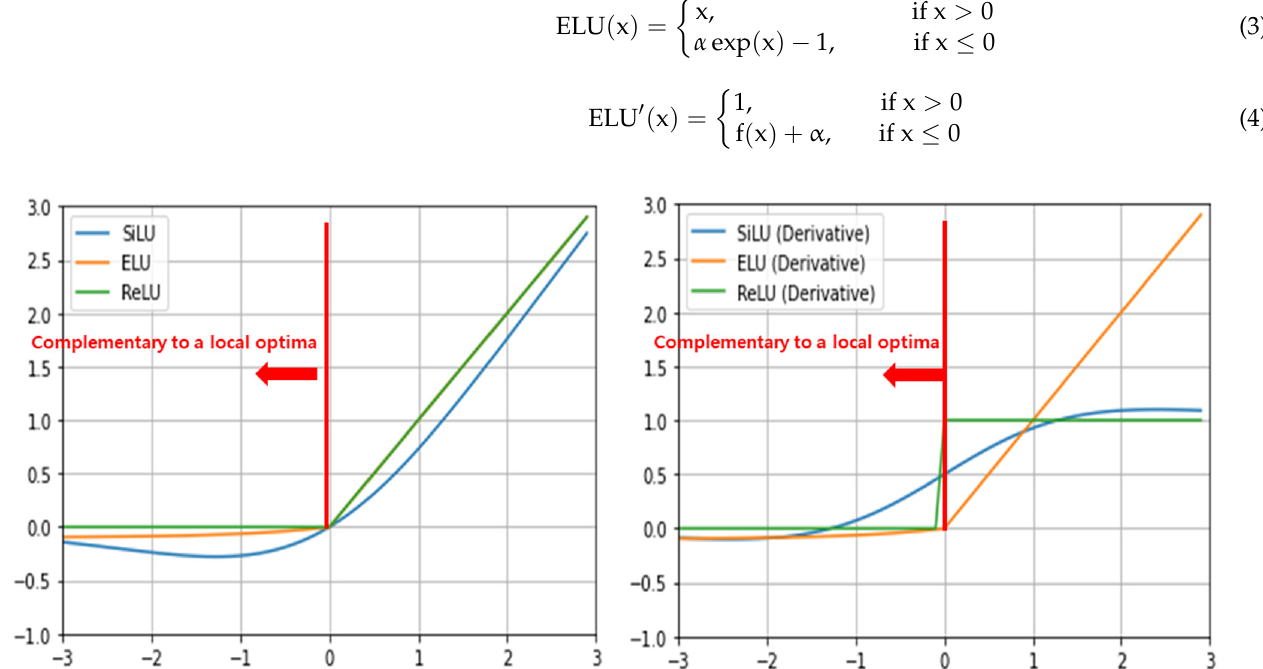
Figure 2. Graph comparison of SiLU, ELU, and ReLU activation function ( Left figure is function, Right figure is a derivative function).